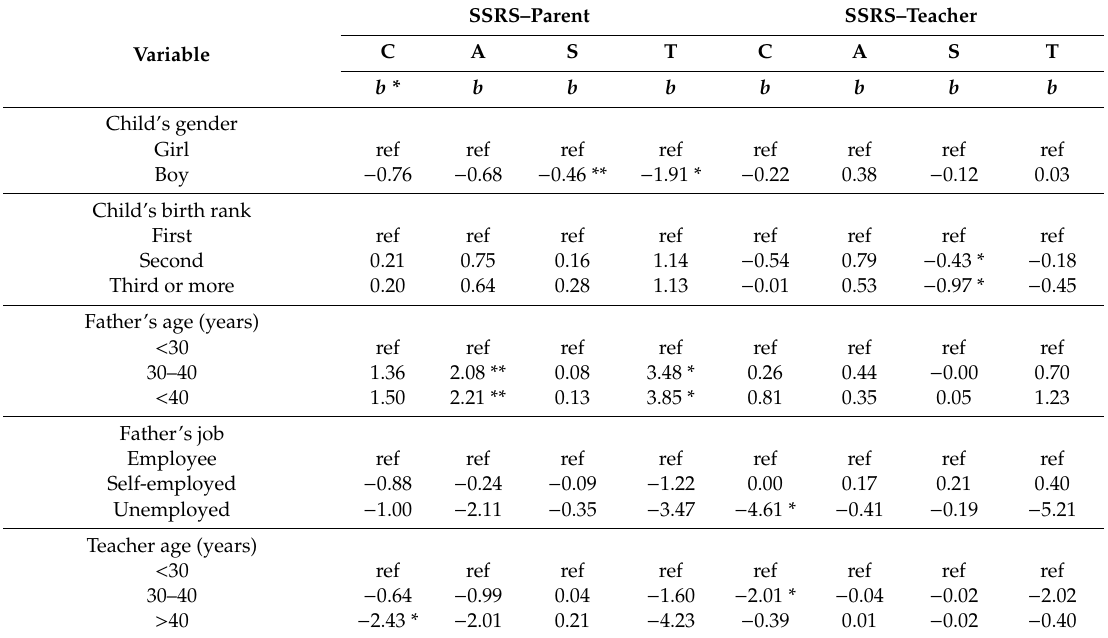
Table 5. Association between sociodemographic variables and social skill domains from the parents’ and teachers’